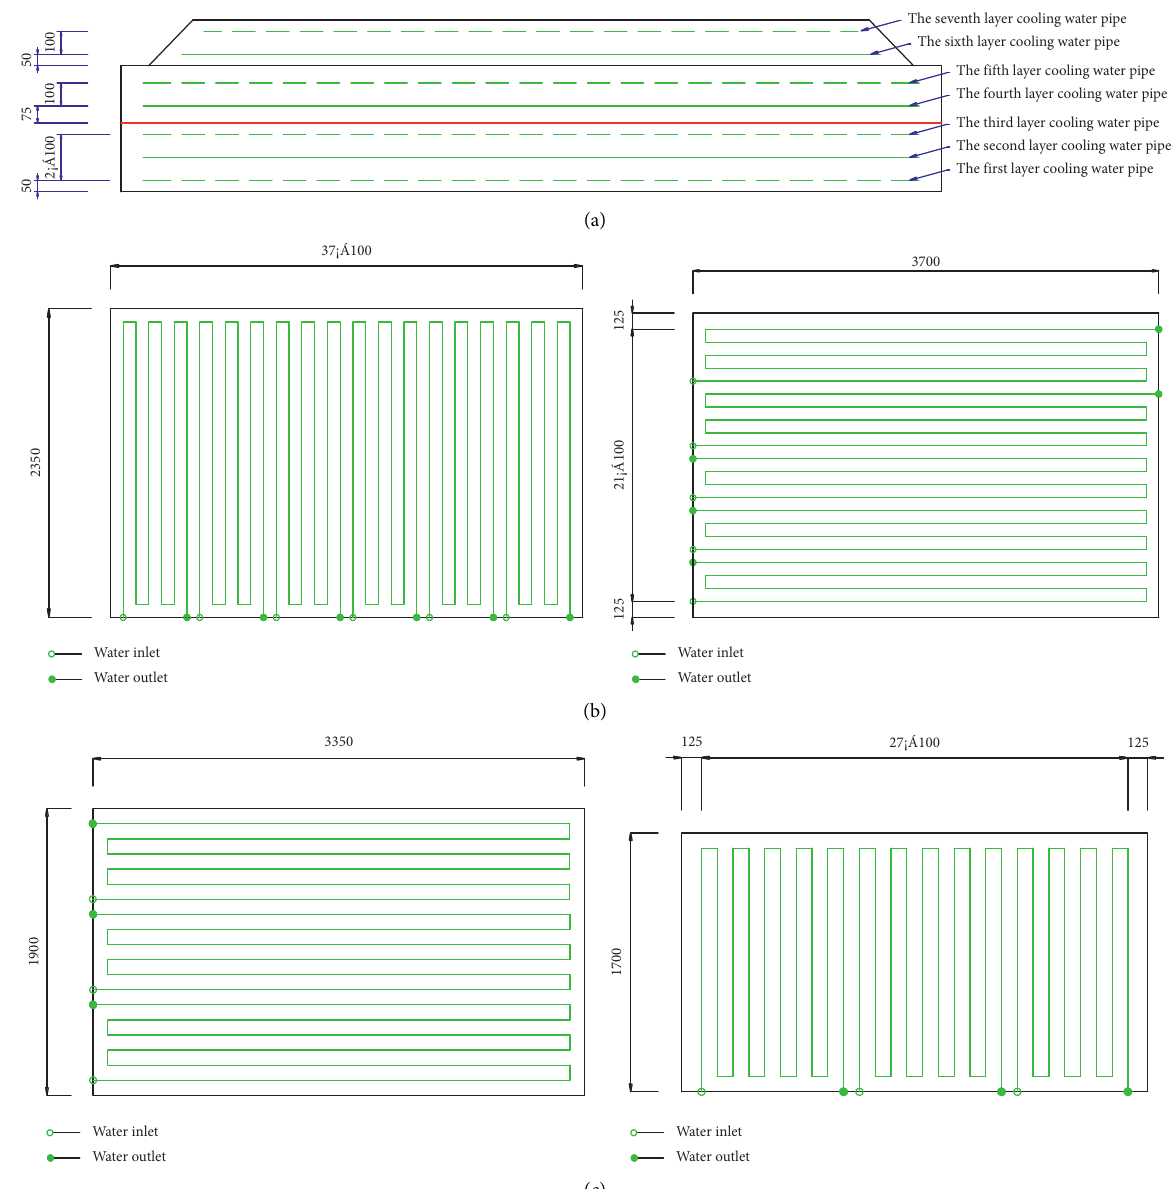
Figure 3: Cooling water pipe layout of cap and tower. (a) Elevation layout of cooling water pipes for cap and tower. (b) Cooling water pipe layout of cap. (c) Tower cooling water pipe layout.